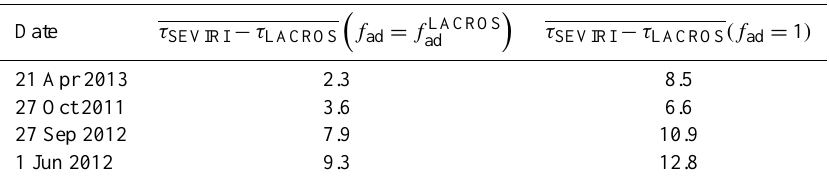
Table 6. Mean difference of τ between SEVIRI and LACROS for each case, when f ad as obtained from the ground-based observations is applied and f ad is considered constantly